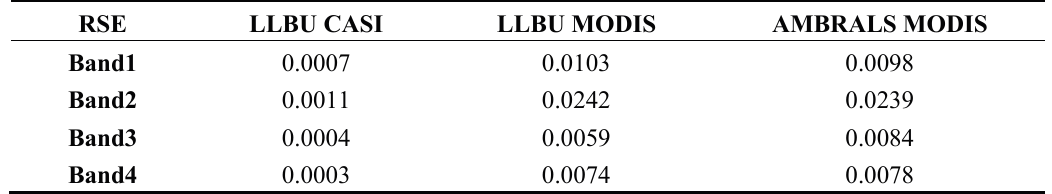
Table 1. The residual standard error (RSE) of fitting the CASI and MODIS reflectances with LLBU or